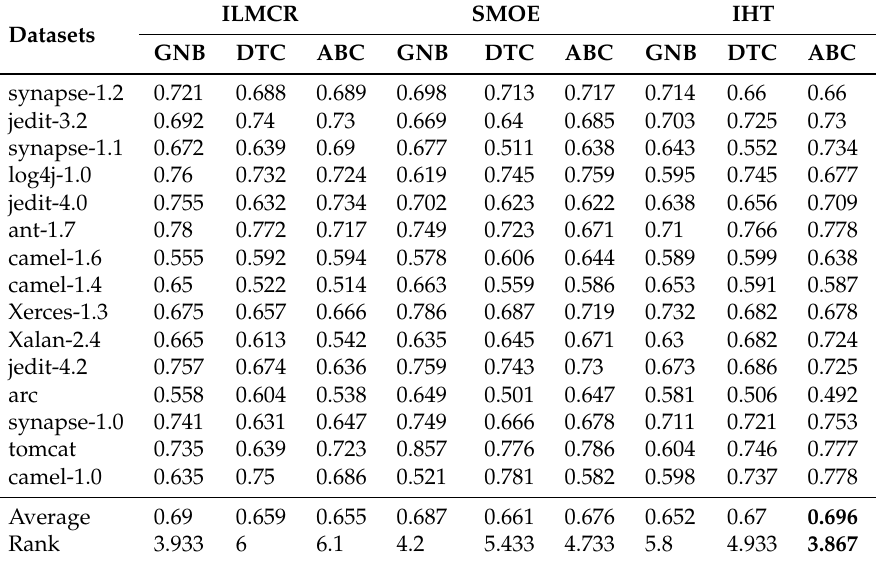
Table 12. G-mean of matching of classifiers with resampling methods on small